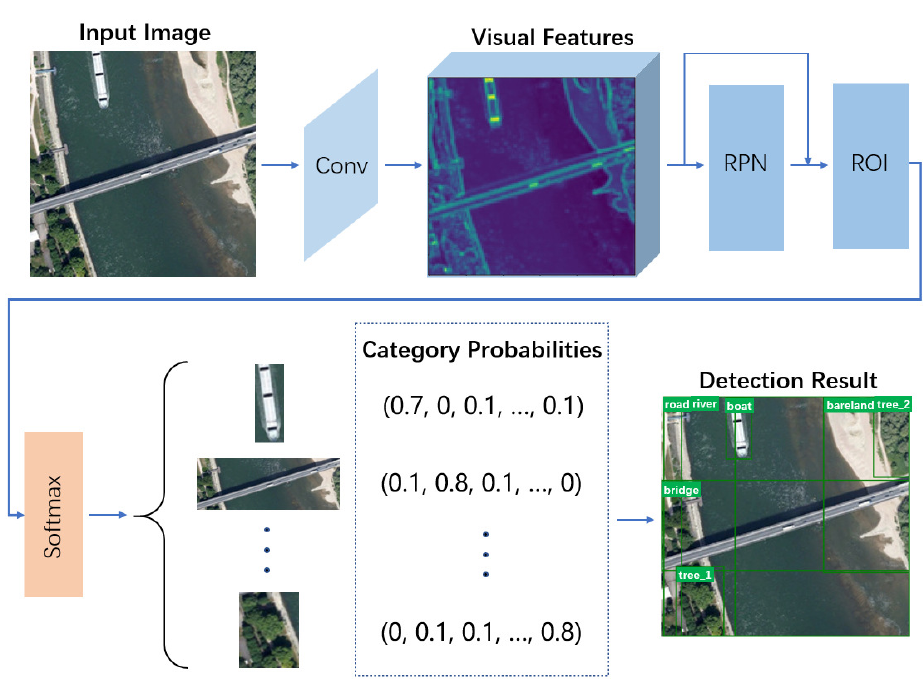
Figure 2. The overview of our proposed MSFN.